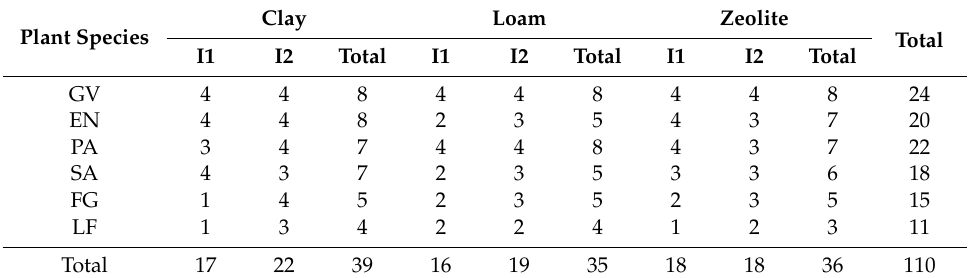
Table 2. Number of plants assessed as moderately healthy to very healthy for each treatment combination (descriptive analysis).